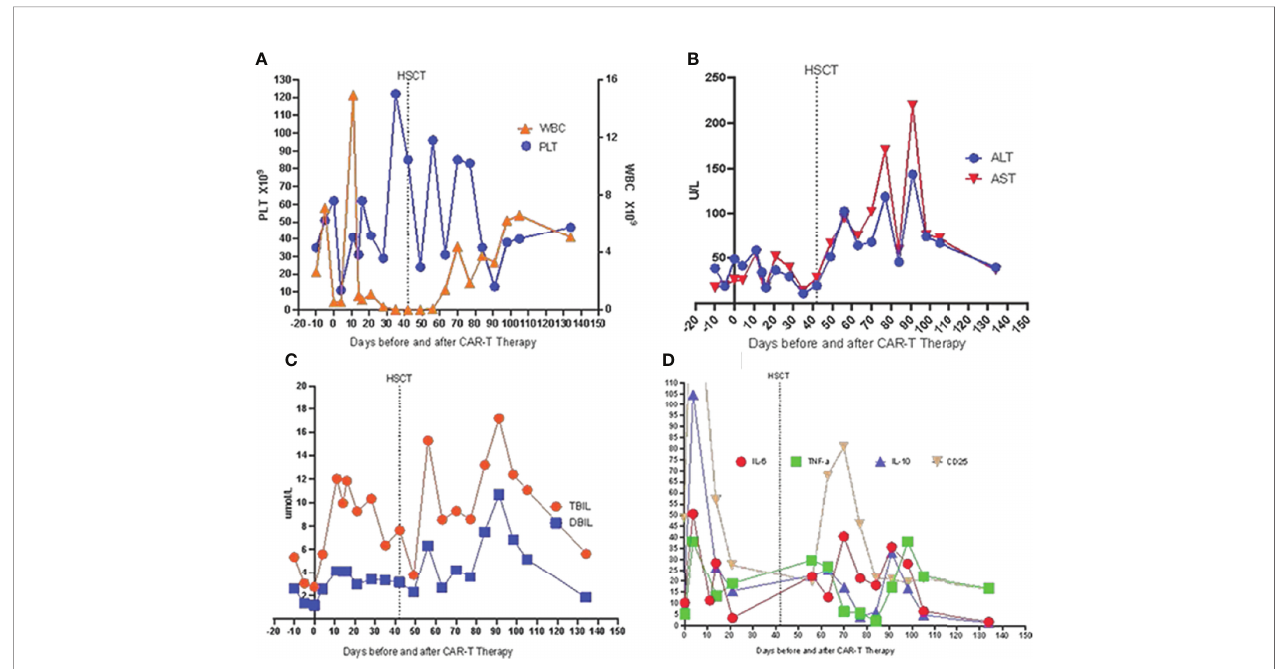
FIGURE 4 | Sequential infusion of anti-CD7 CAR-T therapy bridging to HSCT. (A) Levels of WBC and PLT during CAR-T therapy bridging to HSCT. (B) Levels of ALS and AST during CAR-T therapy bridging to HSCT. (C) Levels of TBIL and DBIL during CAR-T therapy bridging to HSCT. (D) Levels of IL-6, TNF-a, IL-10 and CD25 during CAR-T therapy bridging to